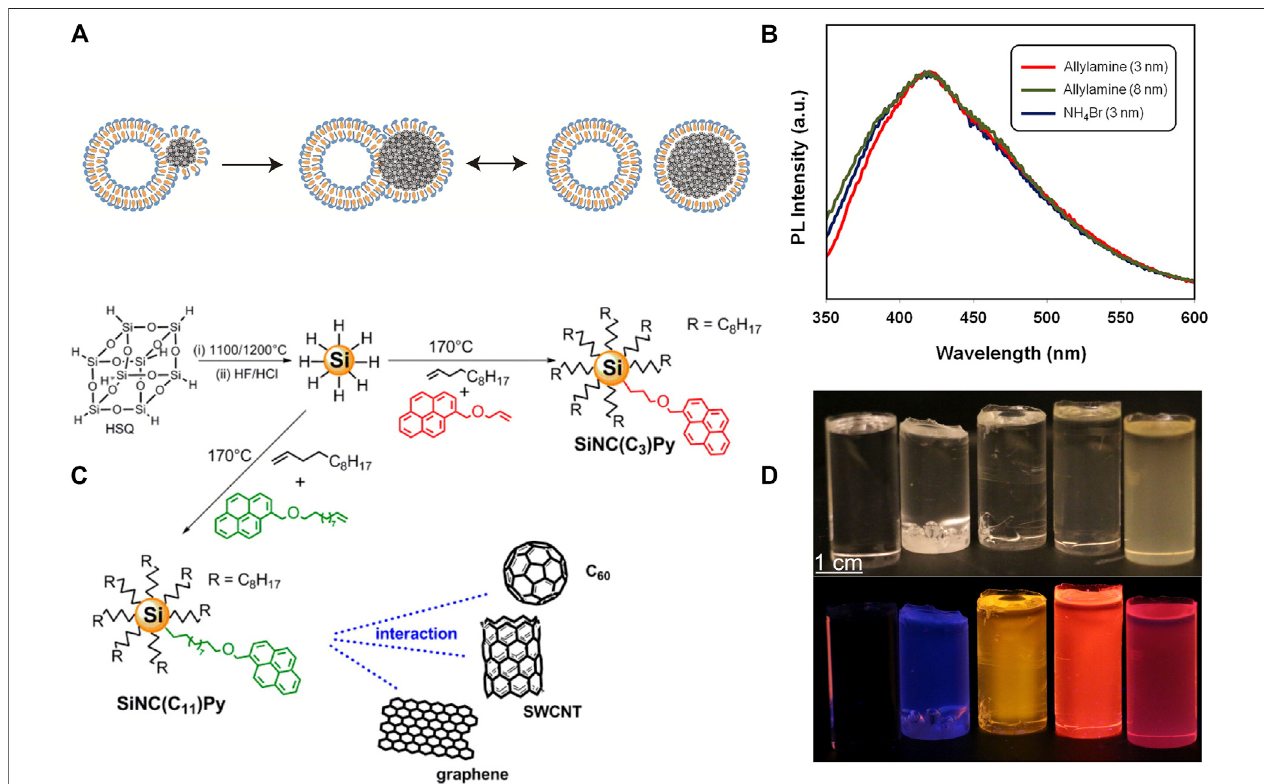
FIGURE5| (A) Scheme oftheinteractionsofSiNCs (solid points) and quatsomes(CTAB istheblue-headedstructure, and cholesterol isthe yellow structure),and the formation of the stable SiNCs covered with a monolayer of quatsomes, reprinted with permission from Silbaugh et al. (2017). Copyright 2017 American Chemical Society. (B) PL spectral of SiNCs with different size and functionalized with NH 4 Br and allylamine, reprinted with permission from Wolf et al. (2013). Copyright 2013 American Chemical Society. (C) Schematic representation of the synthesis process of pyrene-functionalized SiNCs, reprinted with permission from Mazzaro et al. (2015). Copyright 2015 American Chemical Society. (D) The pictures of SiNCs/PMAA under the irradiation of ambient light (top) and UV (bottom) . From left to right were pure PMAA, H-terminated SiNCs/PMAA with smaller SiNCs and bigger SiNCs, and dodecene-terminated SiNCs/PMAA with smaller SiNCs and bigger SiNCs, reprinted with permission from Marinins et al. (2016). Copyright 2016 American Chemical